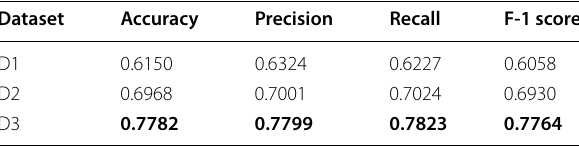
Best value in each column is highlighted in bold